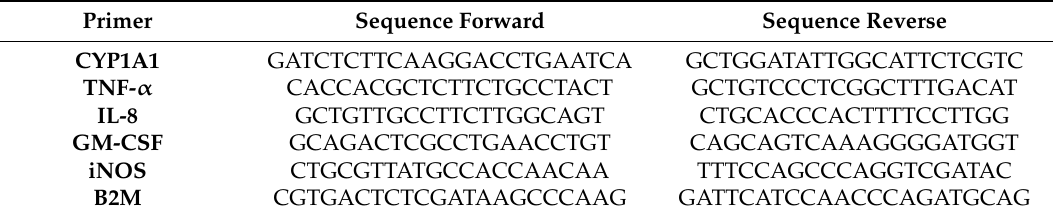
Table A1. Primer pairs for real-time